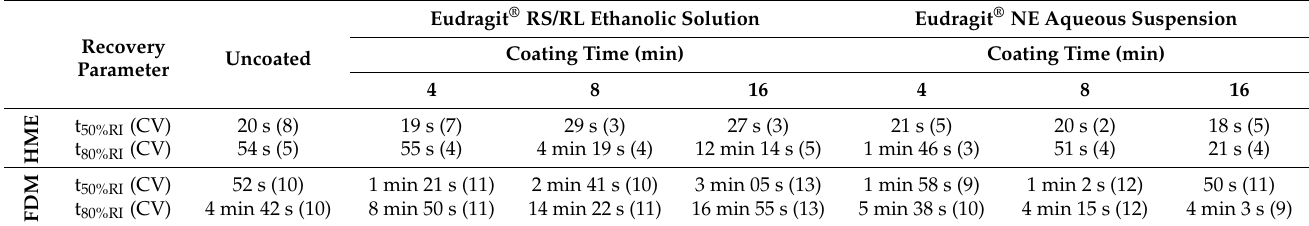
Table 4. Recovery parameters (t 50%RI and t 80%RI ) relevant to uncoated and coated samples.